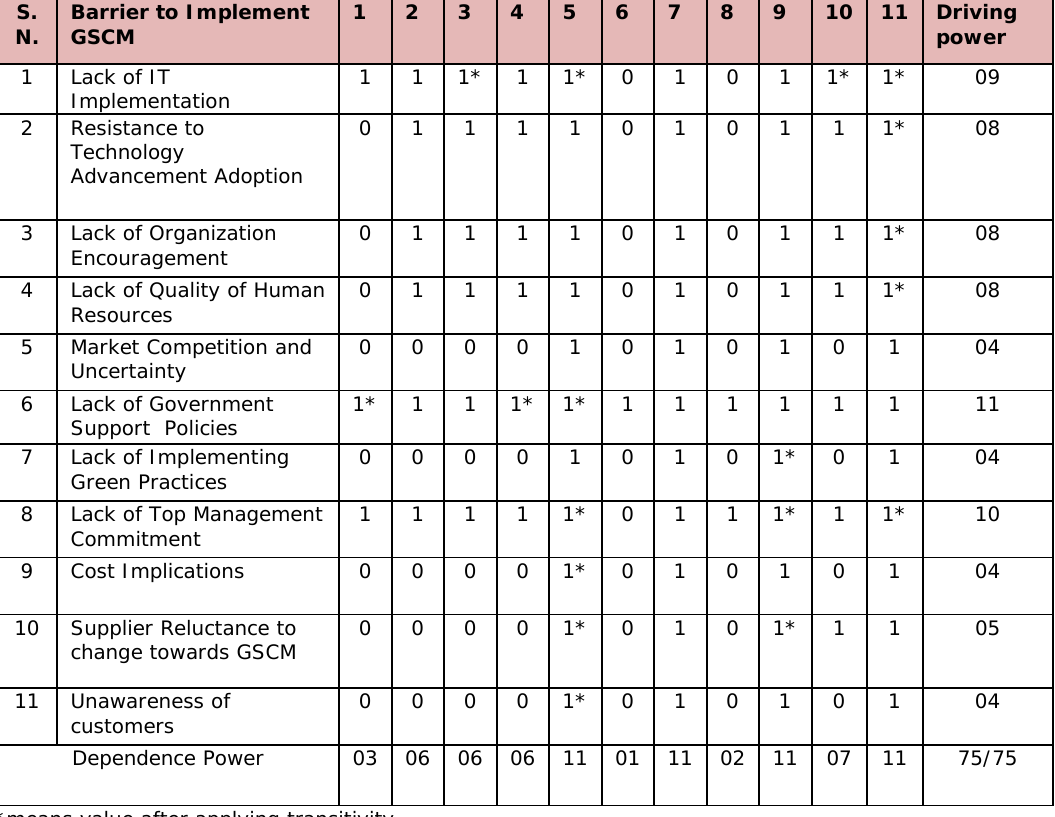
Table 5. “Final Reachablility Matrix for Barriers to Implement GSCM in Indian Automobile